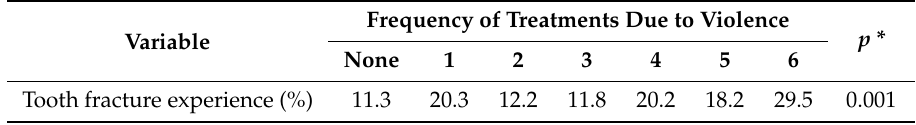
Table 5. Tooth fracture experience by frequency of clinical injury treatments due to violence in the past 12 months.